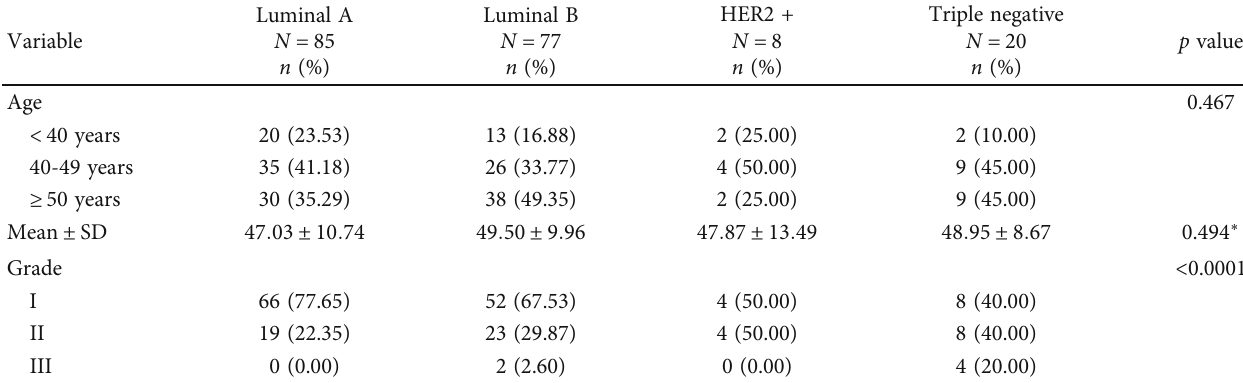
Figure 2: Correlation of Elston-Ellis score and age. Table 2: Age and histoprognostic grade by breast cancer